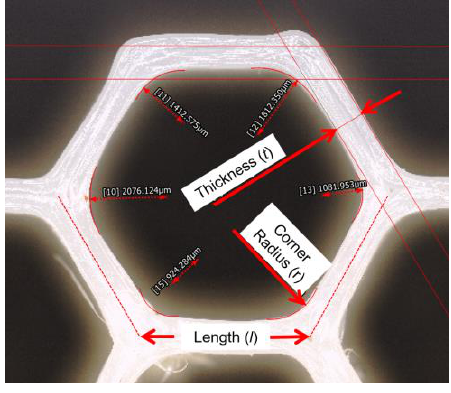
Figure 5. The hexagonal honeycomb can be described in terms of the lengths of its walls ( l ), their thicknesses ( t ), and further, the radius at the corner ( r ).